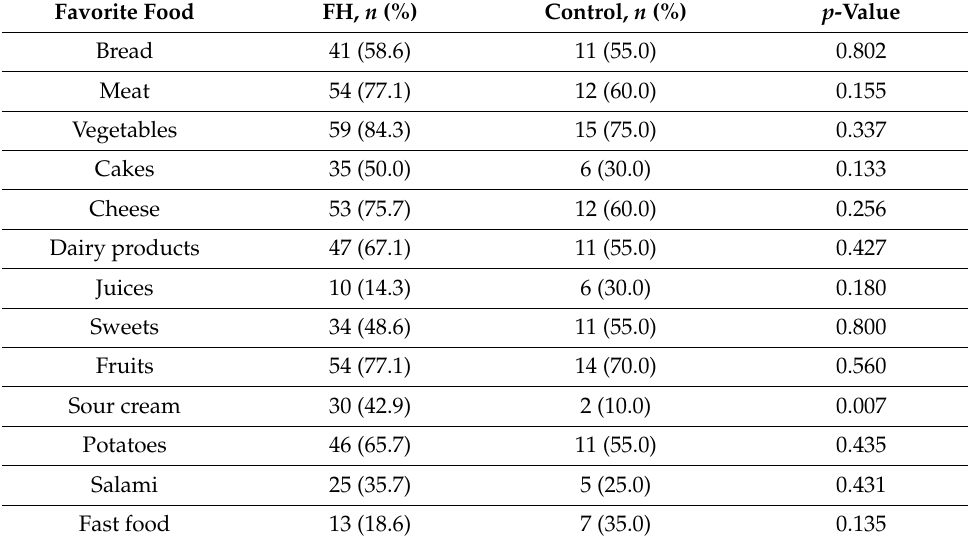
Table 3. Favorite foods.